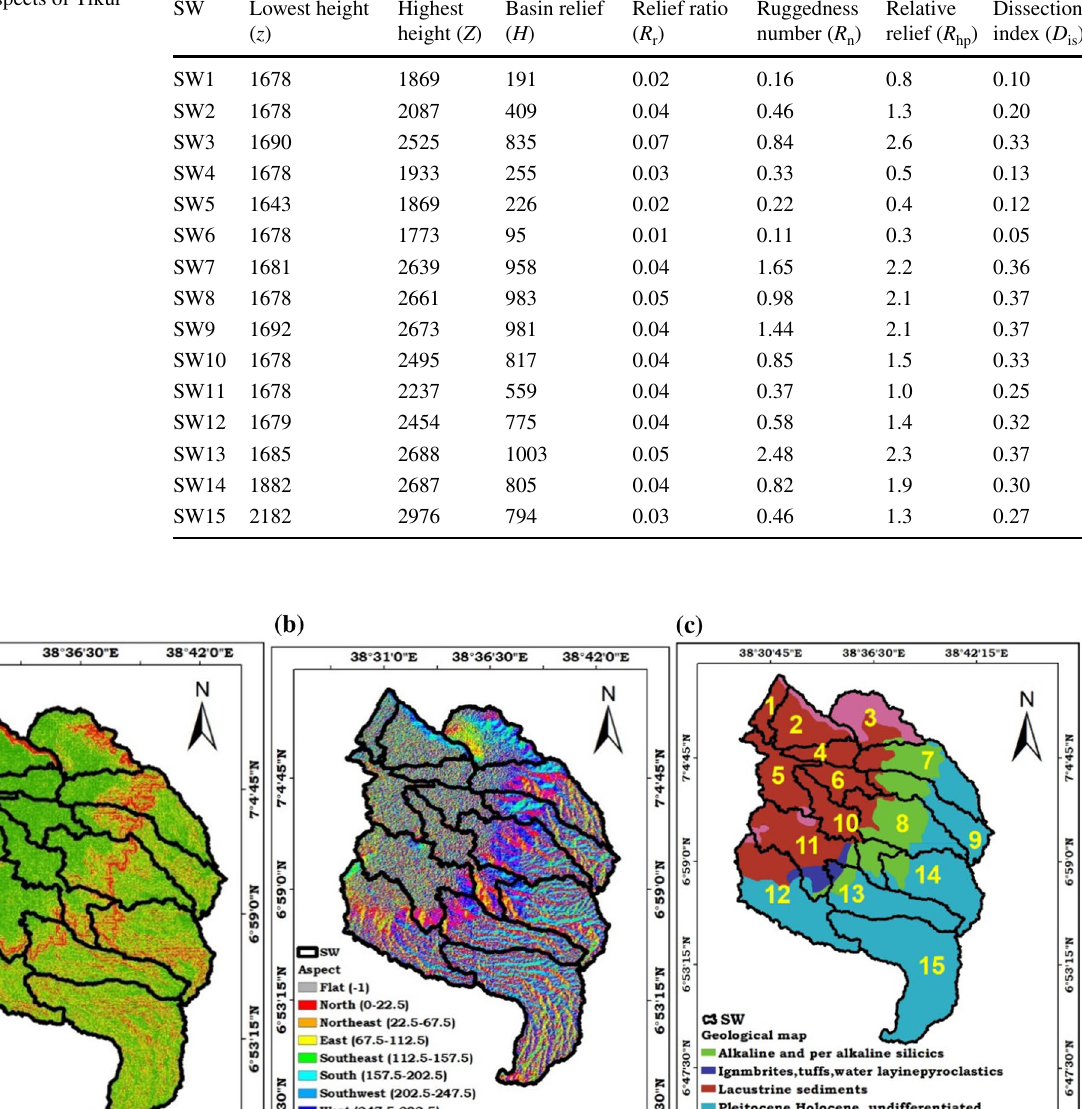
Table 6 Relief aspects of Tikur Wuha river basin